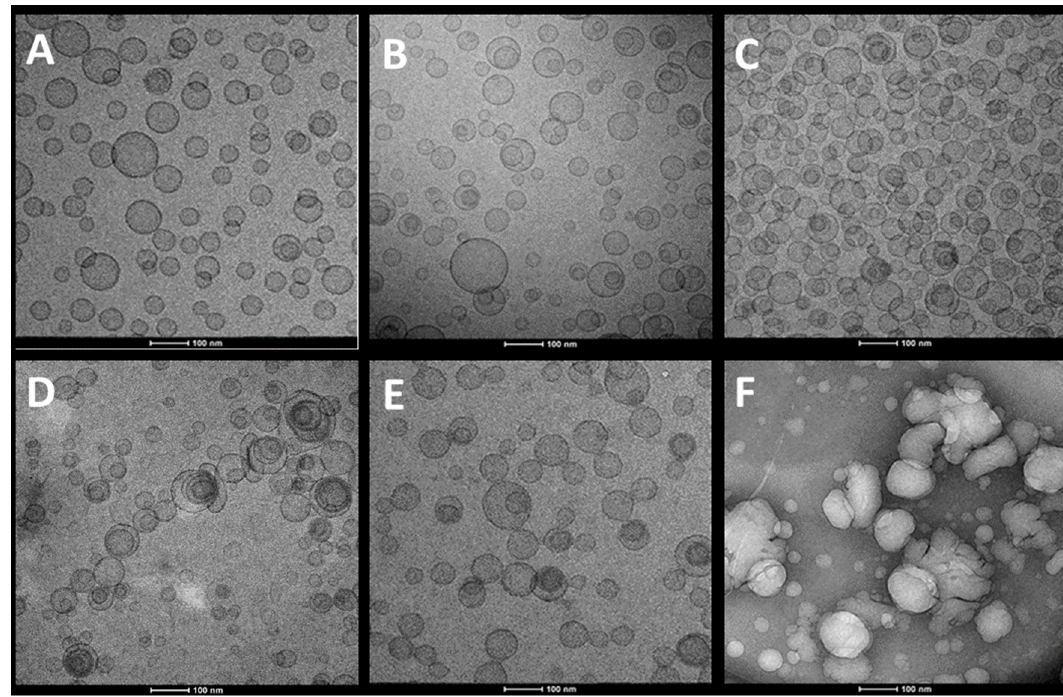
Figure 2. Representative cryo-TEM images of liposomes ( A ), glycerosomes ( B , C ), gluglycerosomes ( D ), gel-gluglycerosomes ( E ), and hyal-gluglycerosomes ( F ), loading H. scruglii extract.